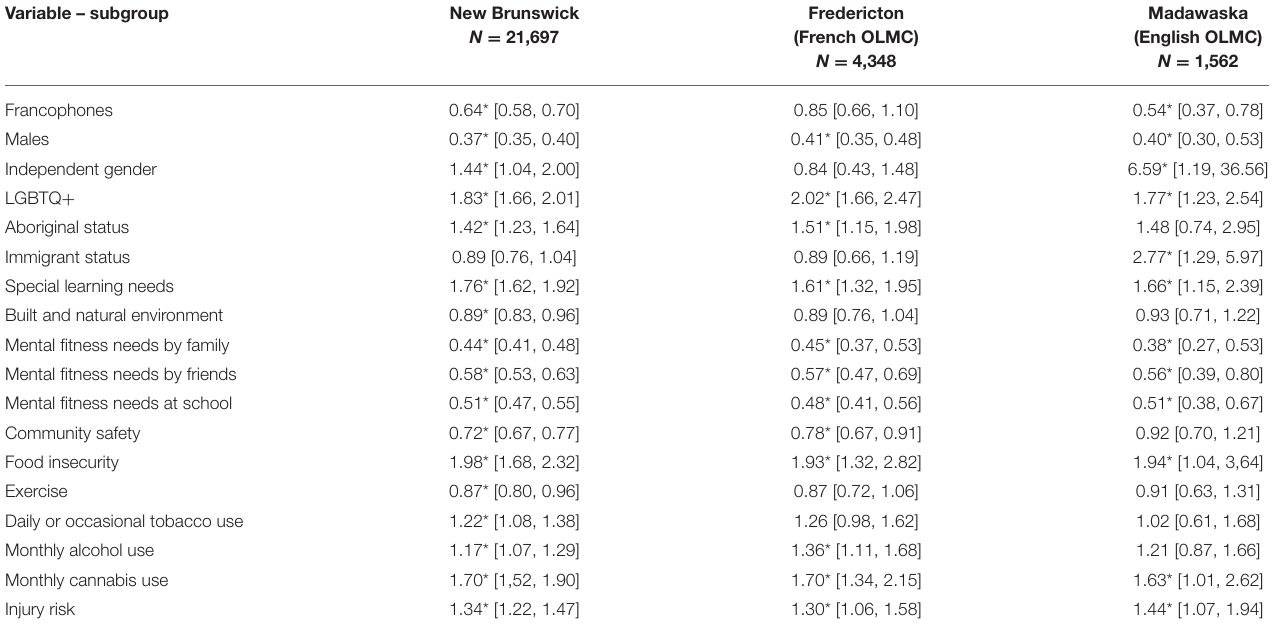
TABLE 3 | Odds ratios and 95% C.I. for symptoms of depression for New Brunswick and two OLMCs. Variable –